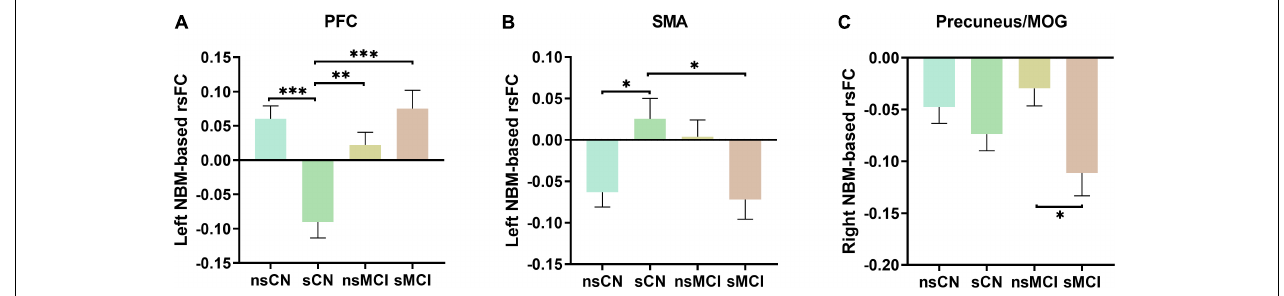
FIGURE 2 | The post hoc analysis of interaction regions of rsFC of the NBM. (A) The smoking CN (sCN) showed significantly decreased rsFC of left NBM to PFC compared to non-smoking CN (nsCN), non-smoking MCI (nsMCI), and smoking MCI (sMCI). (B) The sCN showed increased rsFC of left NBM to SMA compared to nsCN and sMCI. (C) The sMCI showed decreased rsFC of right NBM to precuneus/MOG compared with nsMCI. NBM, nucleus basalis of Meynert; PFC, prefrontal cortex; SMA, supplementary motor area; MOG, middle occipital gyrus. ∗ p < 0.05, ∗∗ p < 0.005, ∗∗∗ p < 0.001.